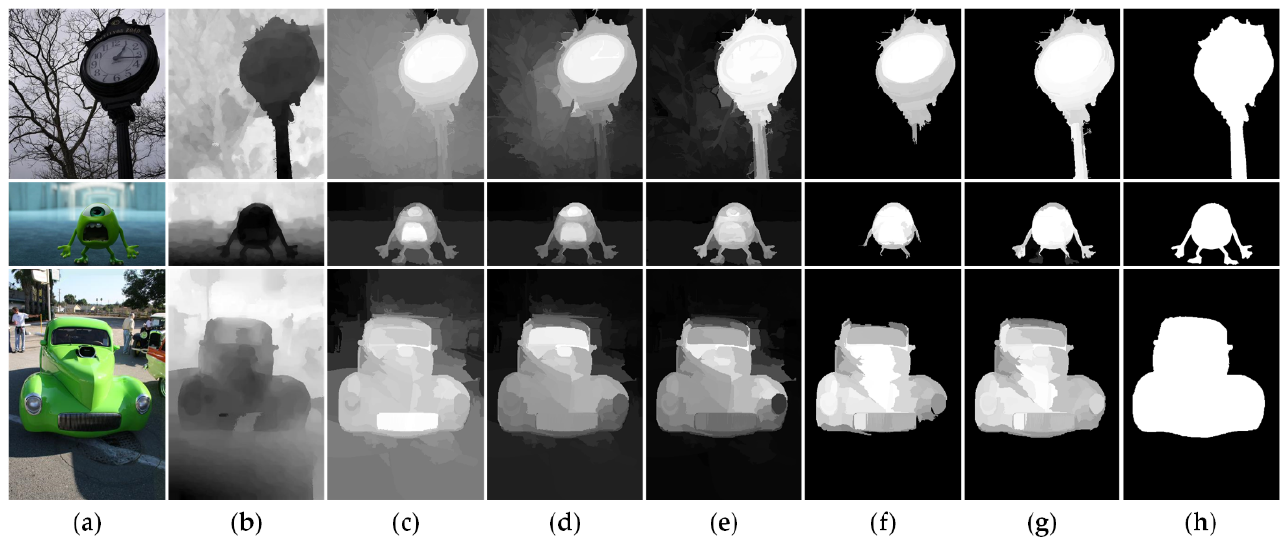
Figure 4. The construction and comparison of the proposed graph model. ( a ) Input RGB image. ( b ) Input depth image. ( c ) Ground truth. ( d ) A diagram of the connections of one of the nodes based on initial two-layer sparse graph. A node (illus- trated by a pink dot) connects to its adjacent nodes (blue dots and connections) and the most similar node (dark green dots and connections) sharing common boundaries with its adjacent nodes. All edge nodes are connected to pairs (yellow dots and local connections). ( e ) A diagram of the connections of one of the nodes based on improved two-layer sparse graph. Different from the initial graph, the new edge nodes first remove some foreground nodes which are in the image boundary (the nodes at the bottom edge of image), and further join a small number of non-edge background nodes (black nodes). Each pair of the new edge nodes connects to each other (yellow and black dots and connections). Additionally, each node connects to the background seeds (light green dots and connections) and the foreground seeds (purple dots and connections).